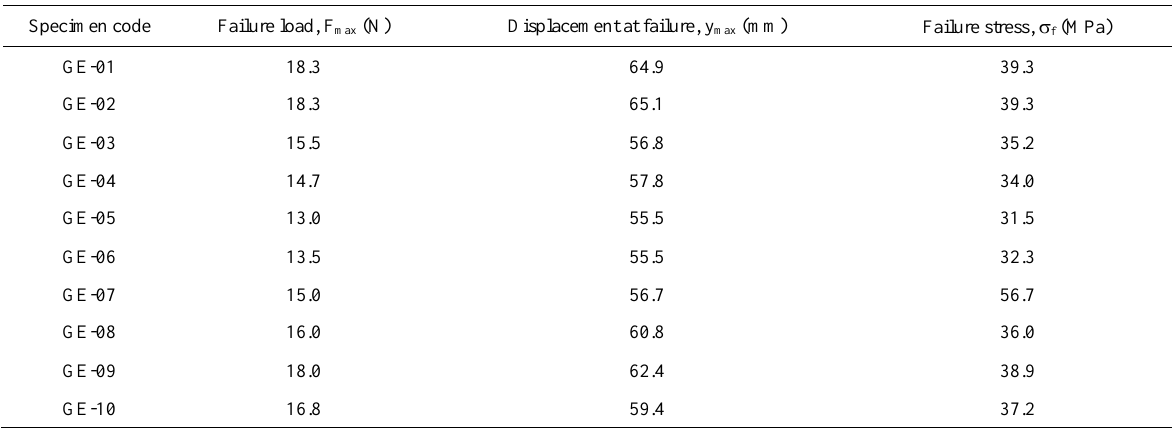
Table 2: Test results for specimens with ground edges, (GE).